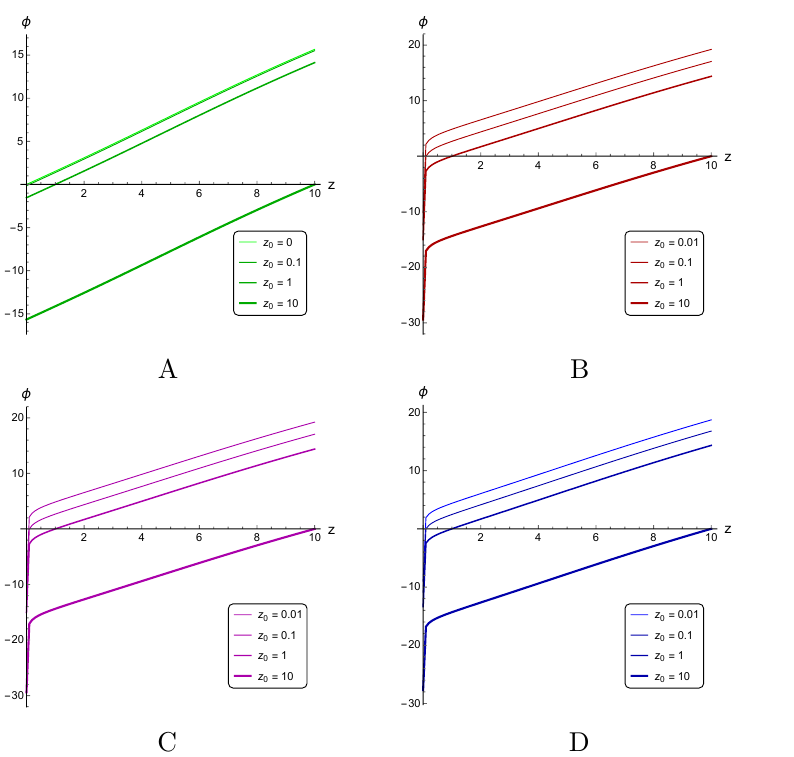
Figure 8 . Scalar field φ ( z ) in isotropic (A) and anisotropic cases for ν = 1 . 5 (B), ν = 3 (C) and ν = 4 . 5 (D) for z 0 = 0 , 0 . 01 , 0 . 1 , 1 , 10 ; a = 4 . 046 , b = 0 . 01613 , c = 0 . 227